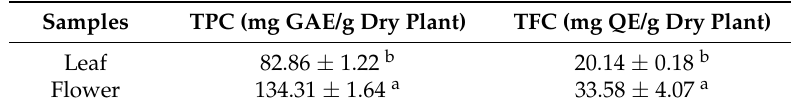
Table 1. TPC (Total Polyphenol Content) and TFC (Total Flavonoid Content) results of the leaf and flower extracts of A. vulneraria in 50% aqueous